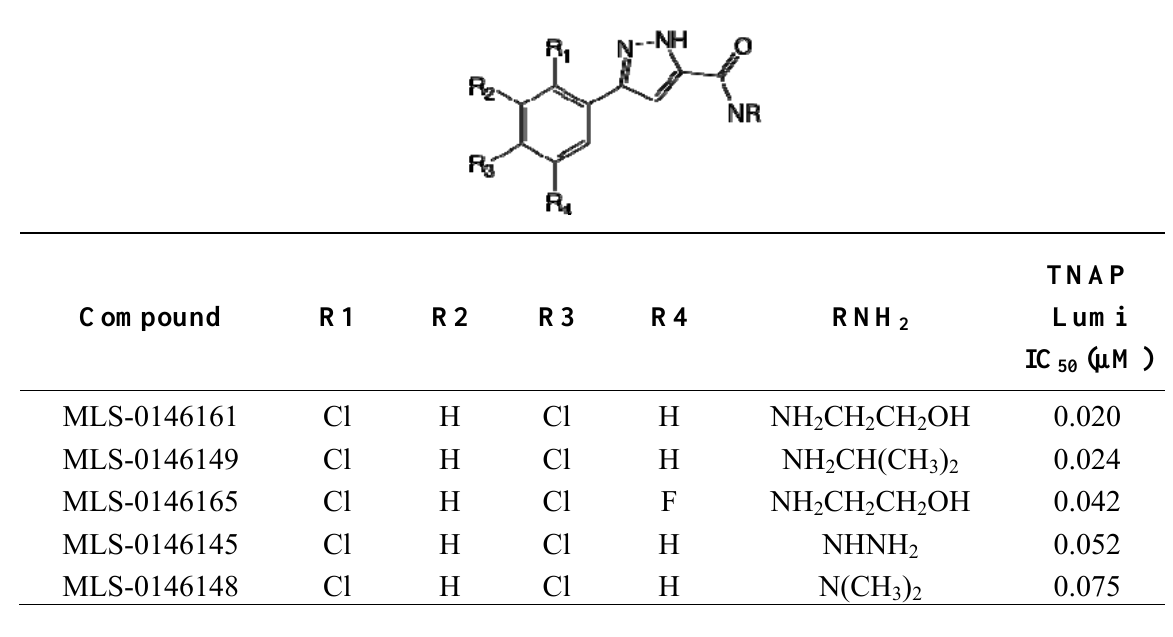
Table 6. SAR on selected analogs of the optimized pyrazole